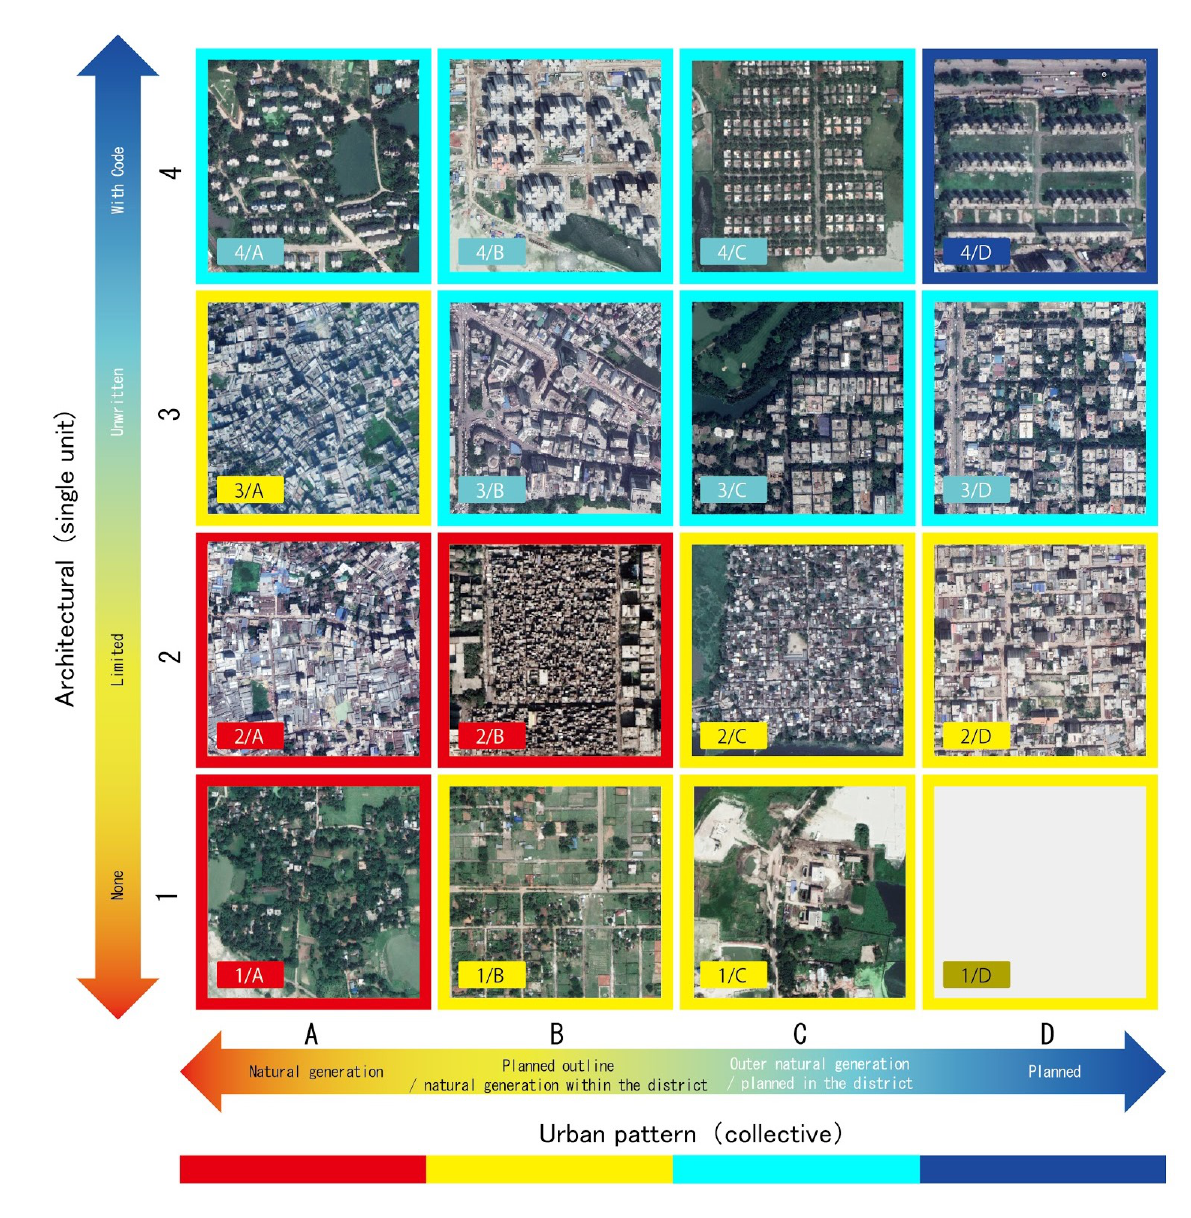
Figure 3. Urban Environment Topology for Cairo, this figure is adapted from [2]. Table 1. Selection of colors for urban environment typology for